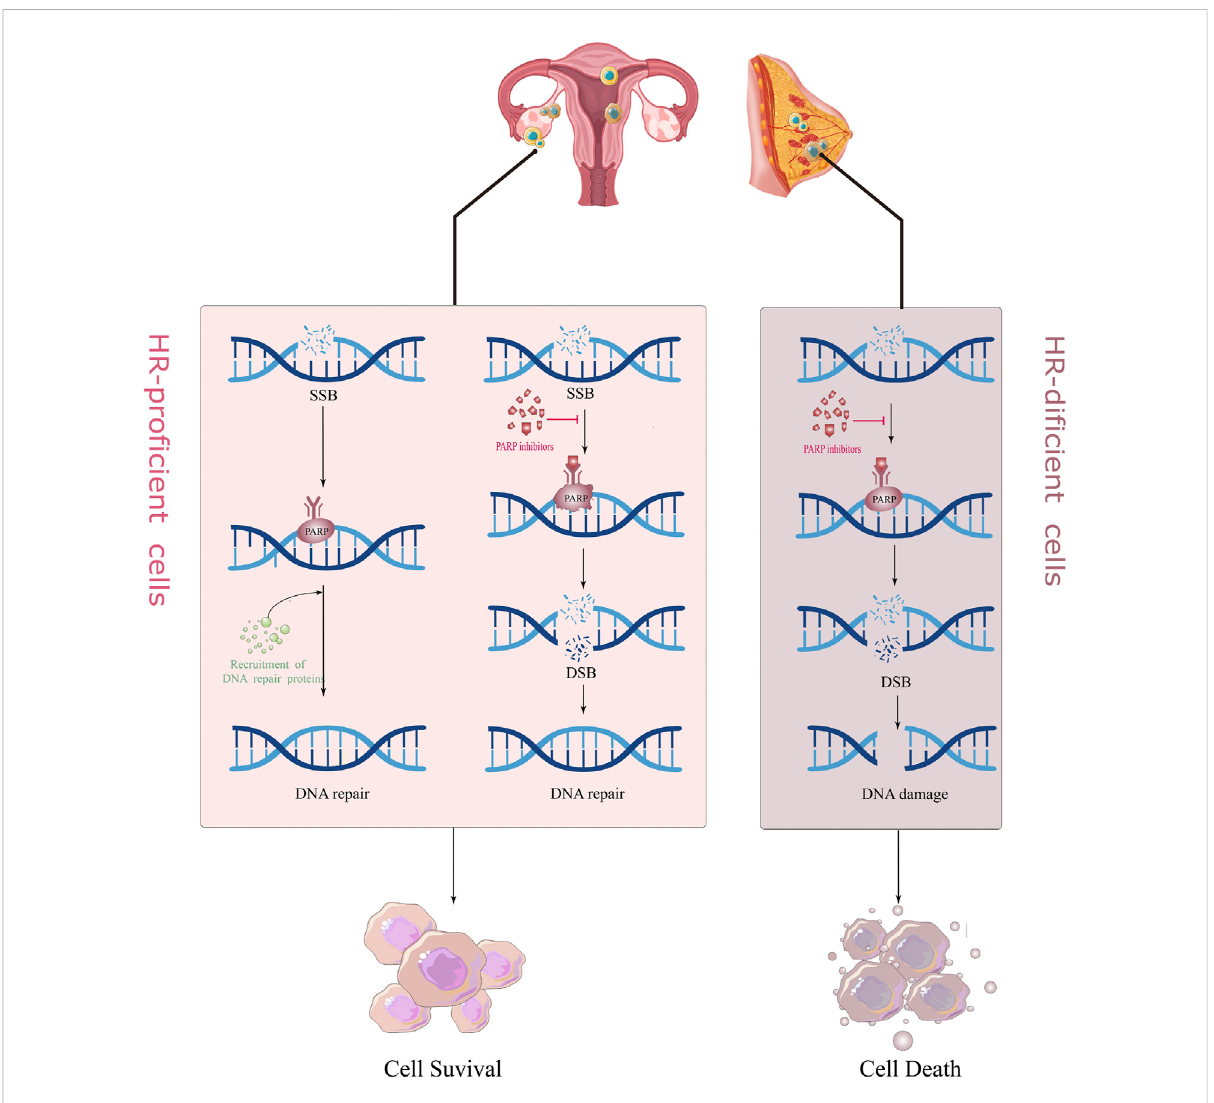
FIGURE 1 The mechanism of action of PARP inhibitors for “ synthetically lethality.